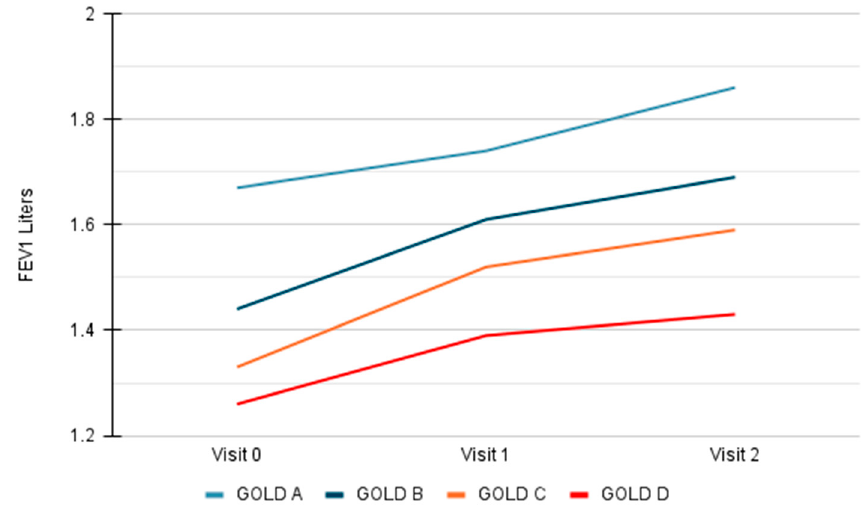
Figure 3. FEV 1 (Liters) per visit based on GOLD COPD 2020 groups.